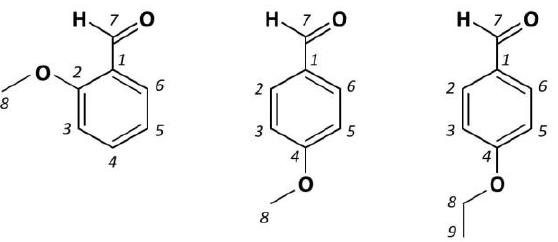
Figure 1. Schematic representation of the 2-methoxy, 4-methoxy, and 4-ethoxybenzaldehyde molecules. The molecules display a planar heavy-atom skeleton and adopt the anti-conformation (C=O and O–C(8) bonds pointing to opposite sides of the ring).